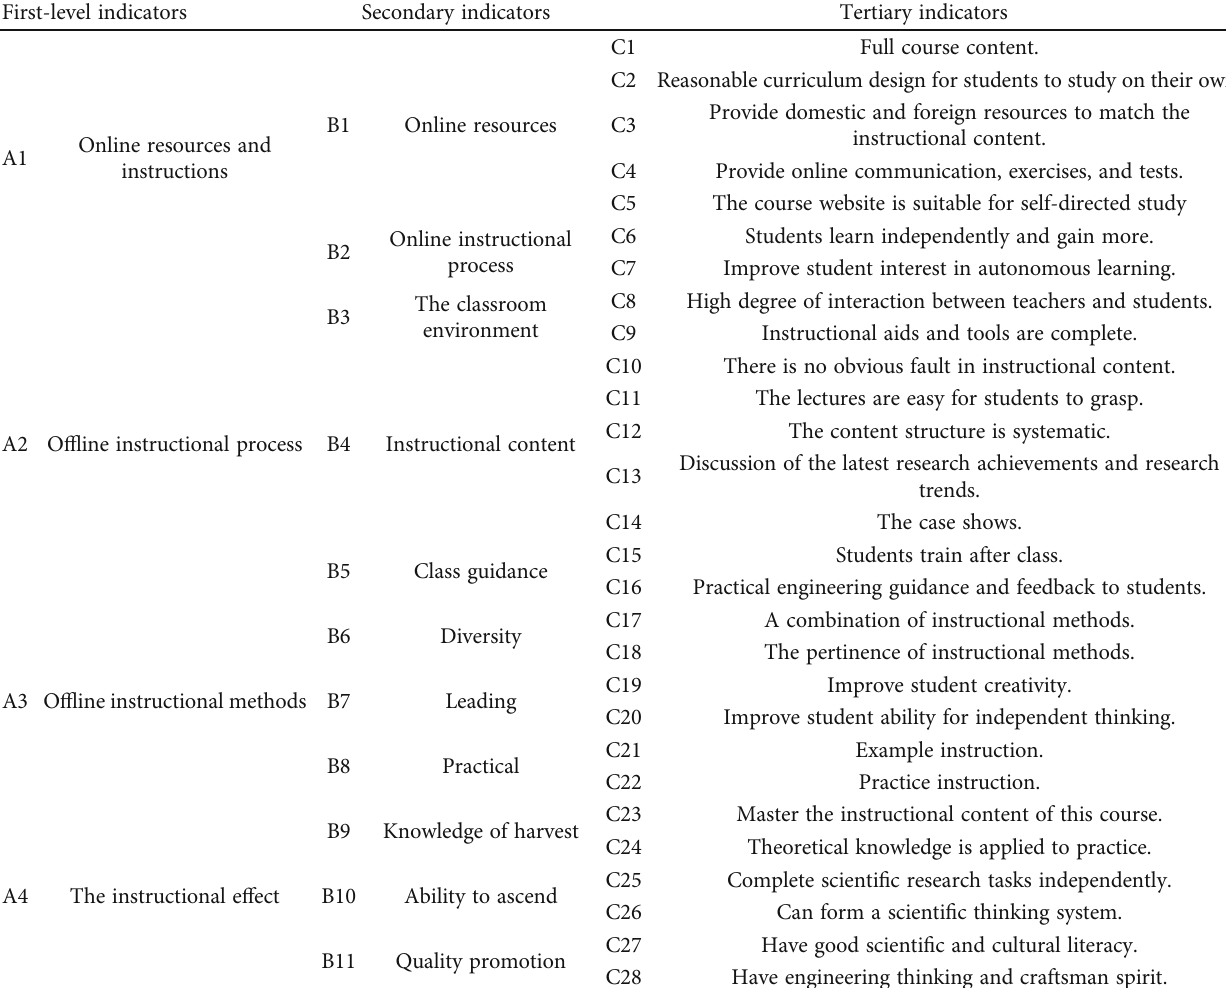
Table 4: Instructional quality evaluation index system.